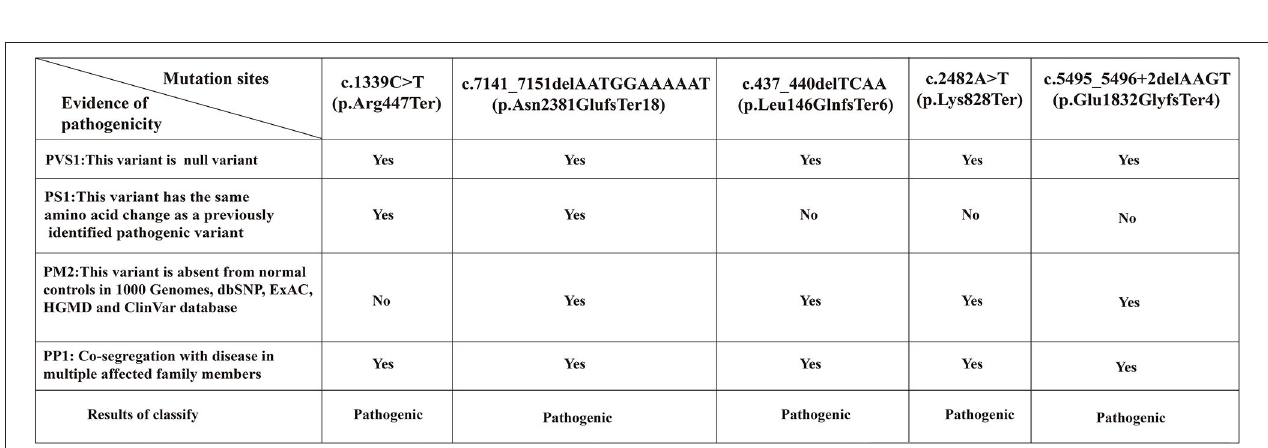
FIGURE 8 | The reasons for classifying the pathogenicity of ATM mutation sites in 3 pedigrees. According to the UK-ACGS Best Practice Guidelines for Variant Classification in Rare Disease 2020, the variants with evidence for one PVS1 plus ≥ one PS or one PVS1 plus ≥ one PM are classified as Pathogenic Variants. PVS, very strong pathogenicity; PS, strong pathogenicity; PM, moderate pathogenicity; PP, supporting